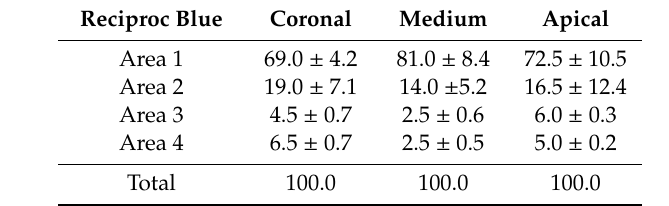
Table 6. Root canal areas expressed as percentages (mean ± SD) of analyzed teeth using Reciproc Blue instrumentation.